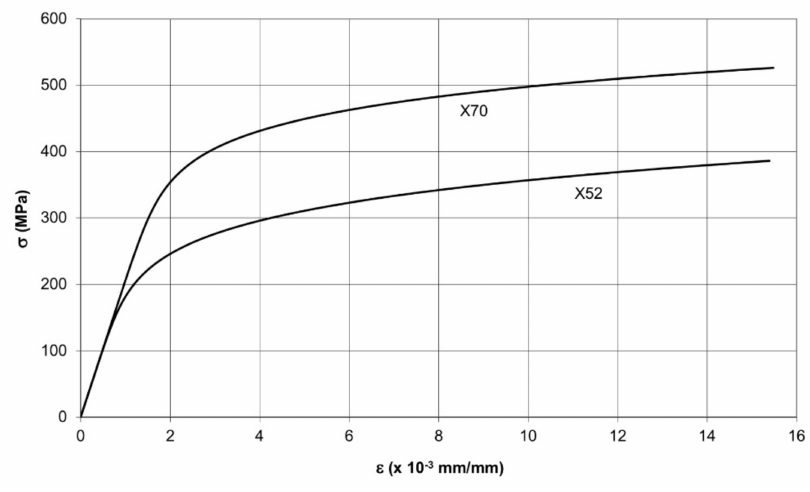
Figure 5. The stress-strain curves for the steels used. Table 1. The Ramberg–Osgood parameters and ultimate strengths of the steels